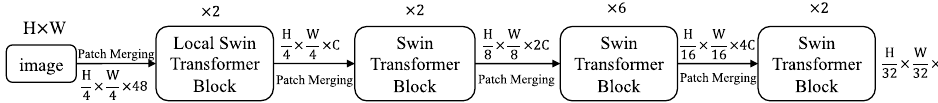
Figure 5. Swin transformer architecture with contextual information enhanced.